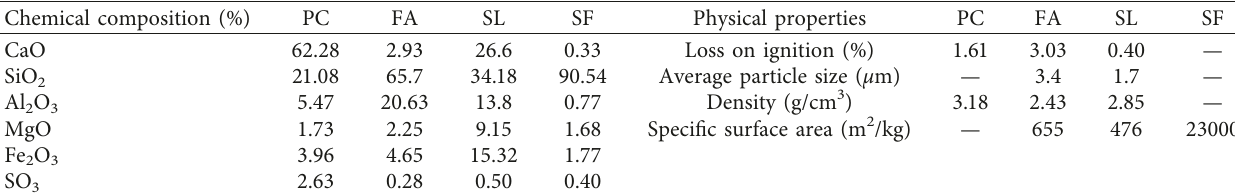
Table 1: Physical properties and chemical compositions of raw materials.